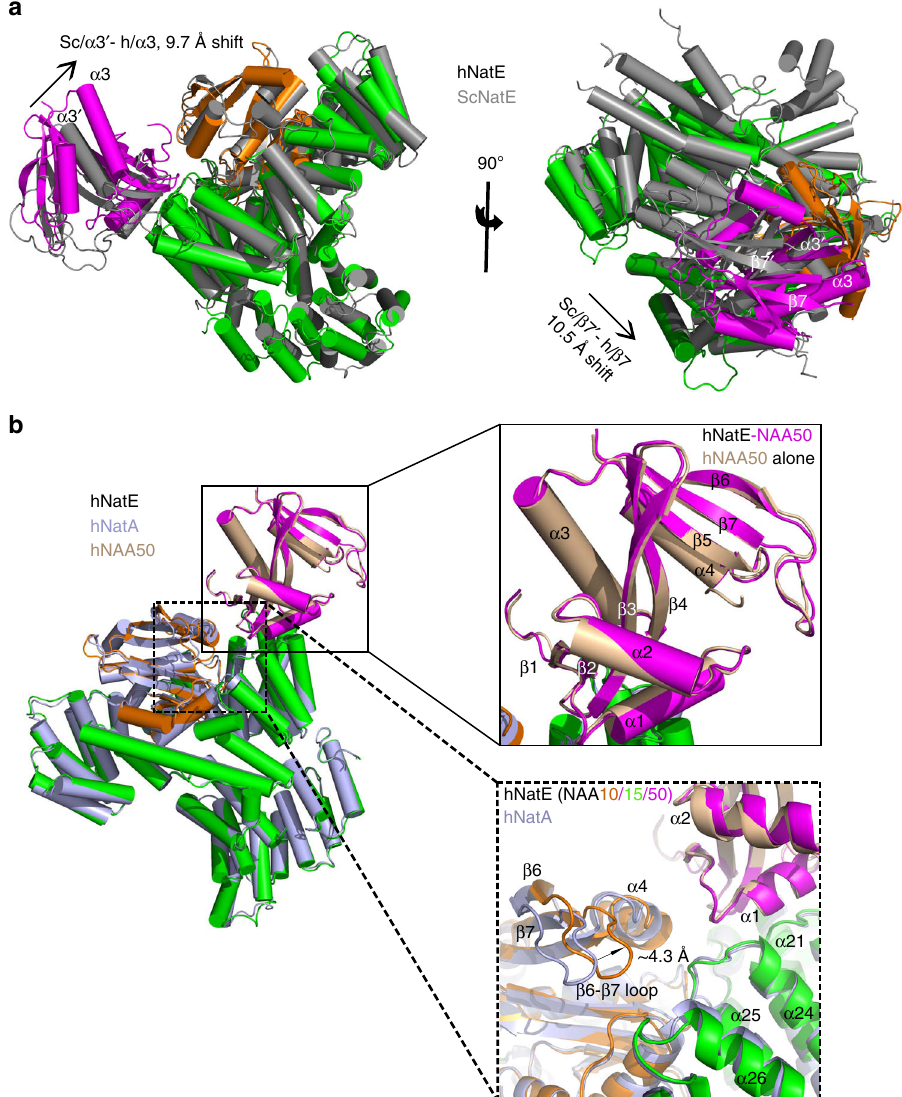
Fig. 5 Subunit crosstalk within the hNatE complex. a hNAA50(magenta), hNAA15(green), and hNAA10(orange) within the hNatE complex overlay with ScNatE (gray, PDB: 6O07). The α 3 helix and β 7 strand of Naa50 is shown to shift toward Naa10 in the human structure ( b ) hNatE aligned with hNatA (light blue, PDB:6C9M) and hNAA50 (wheat, PDB: 3TFY). The top zoom-in area shows the alignment of free hNAA50 and hNatE. The below zoom-in area shows the hNAA10 conformational change induced by hNAA50